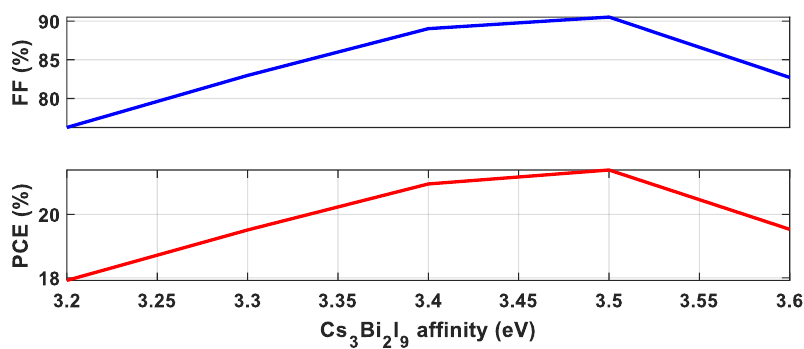
Figure 8. Effect of Cs 3 Bi 2 I 9 electron affinity on the performance parameters.